Question: Which visualization type does this figure use?
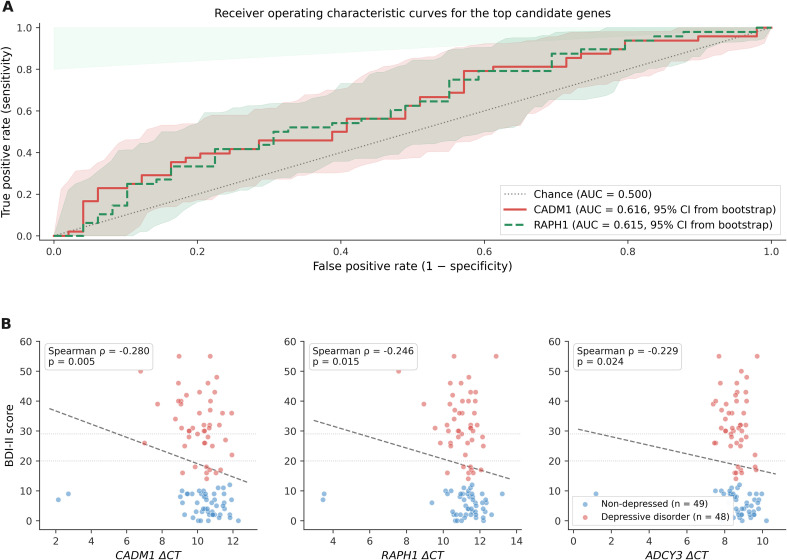
Answer: scatter